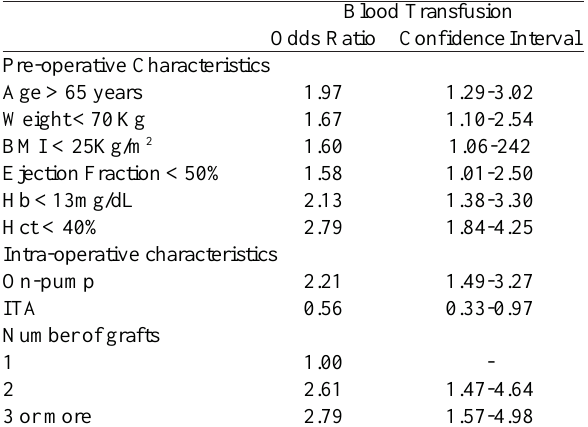
Table 2. Transfusion risk according to univariate analysis of perioperative variables associated with blood transfusion.